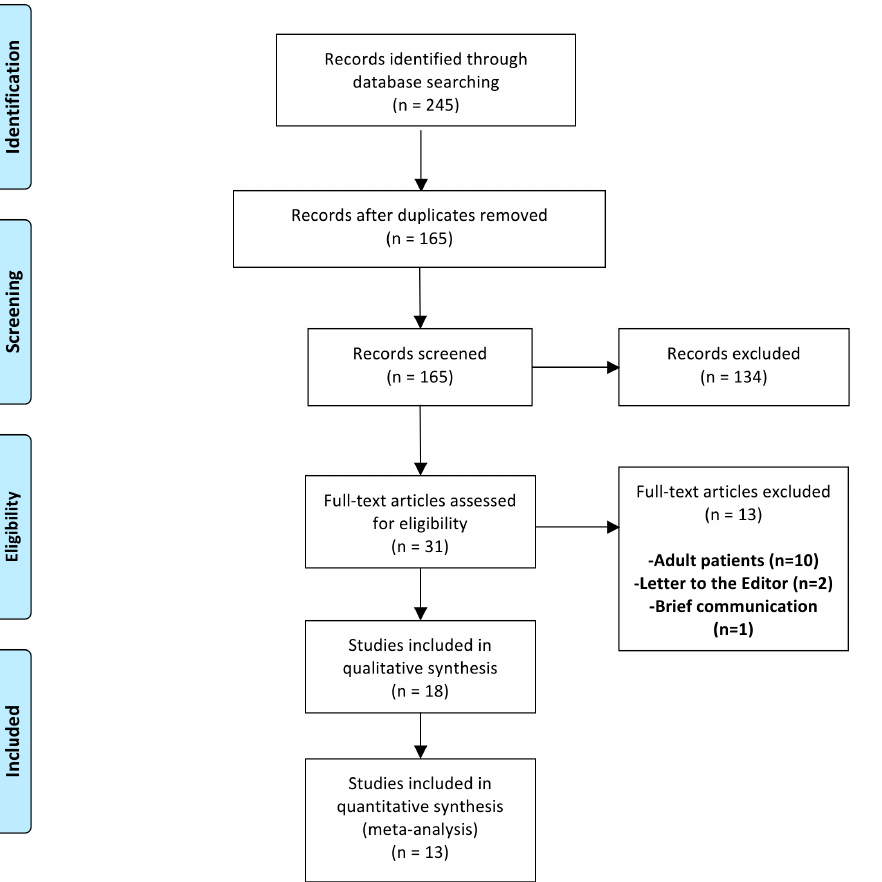
Figure 1. Selection of the relevant studies using the Preferred Reporting Items for Systematic Review and Meta-Analysis (PRISMA) flow diagram.